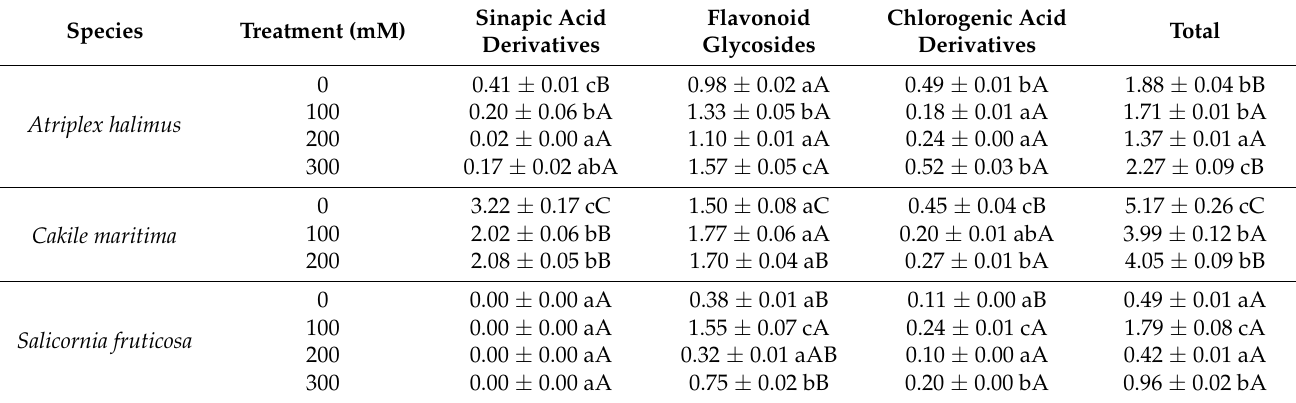
Table 3. Flavonoid glycosides, Sinapic and Chlorogenic acid derivatives, and Total (as the sum of all) in the leaves and stems of Atriplex halimus , Cakile Maritima , and Salicornia fruticosa , (mg g − 1 DW) under different treatments (0, 100, 200, and 300 mM NaCl). Means ( n = 5 ± SE) with different letter are significantly different at p -value < 0.05; different lower-case letters are significantly different among the same species under different treatments, and different capital letters are significantly different among different species under the same treatment. Tukey HSD test was used for mean comparison.